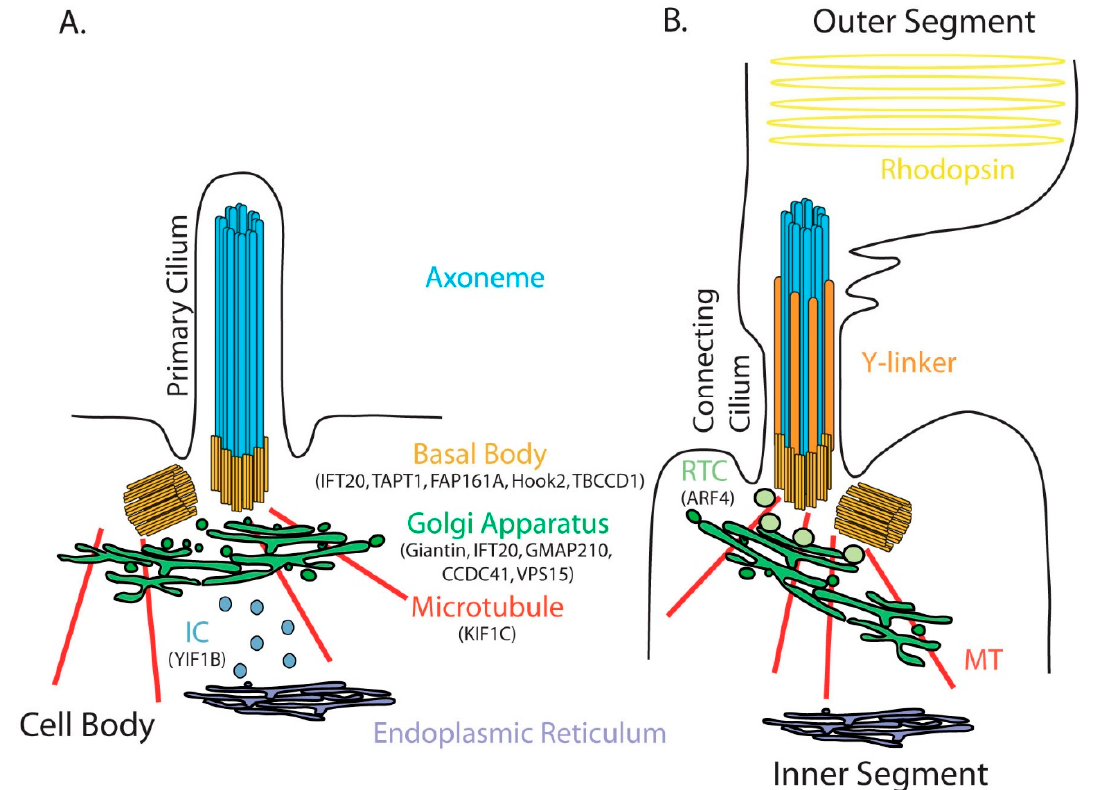
Figure 1. Schematic representation of the primary ( A ) and connecting cilium ( B ). The axoneme contains nine pairs of microtubules grown from the mother centriole differentiated into a basal body. The Golgi apparatus is anatomically closely related to the cilium. In photoreceptors, the connecting cilium links the photoreceptor inner and outer segments and has a specialized transition zone composed of Y-linkers and specialized post-Golgi rhodopsin carriers (RTC) that allow the targeting of rhodopsin to the outer segment. IC is the intermediate compartment between the endoplasmic reticulum and the Golgi apparatus. Microtubules allow dynein-dependent trafficking between the centrioles and the Golgi apparatus. All proteins mentioned in the manuscript as being involved in ciliogenesis/ciliary function appear in their resident compartment.